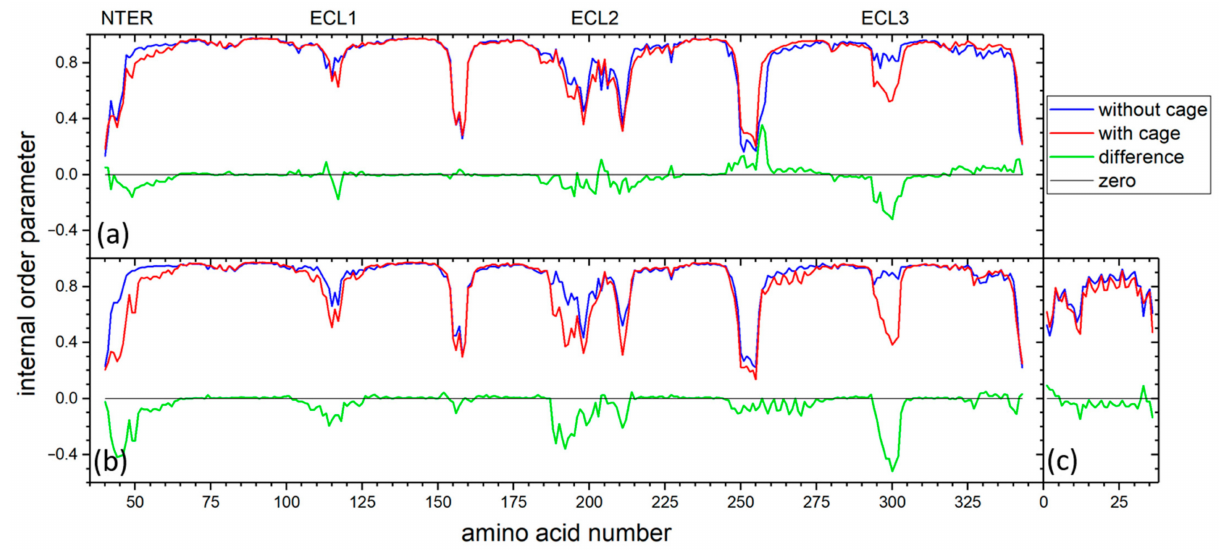
Figure 6. Internal order parameters of all amino acids in apo Y2R-A202C ( a ) and for both Y2R-A202C ( b ) and NPY ( c ) in the Y2R-A202C/NPY complex. Data in presence of construct are shown in red, while data without CrA-Cy3-mal are shown in blue. Their difference is shown in green, while a line at zero is shown in black for